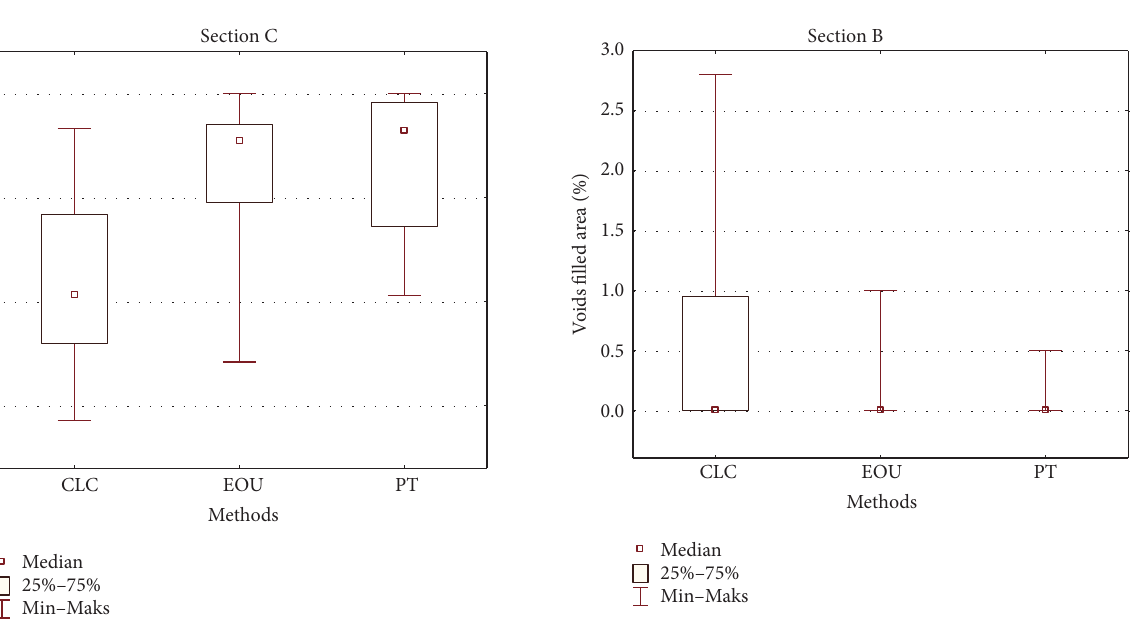
Figure 9: Box plots illustrating the median traces and minimal and maximal values of the gutta-percha-filled area in each experimental group, section C.